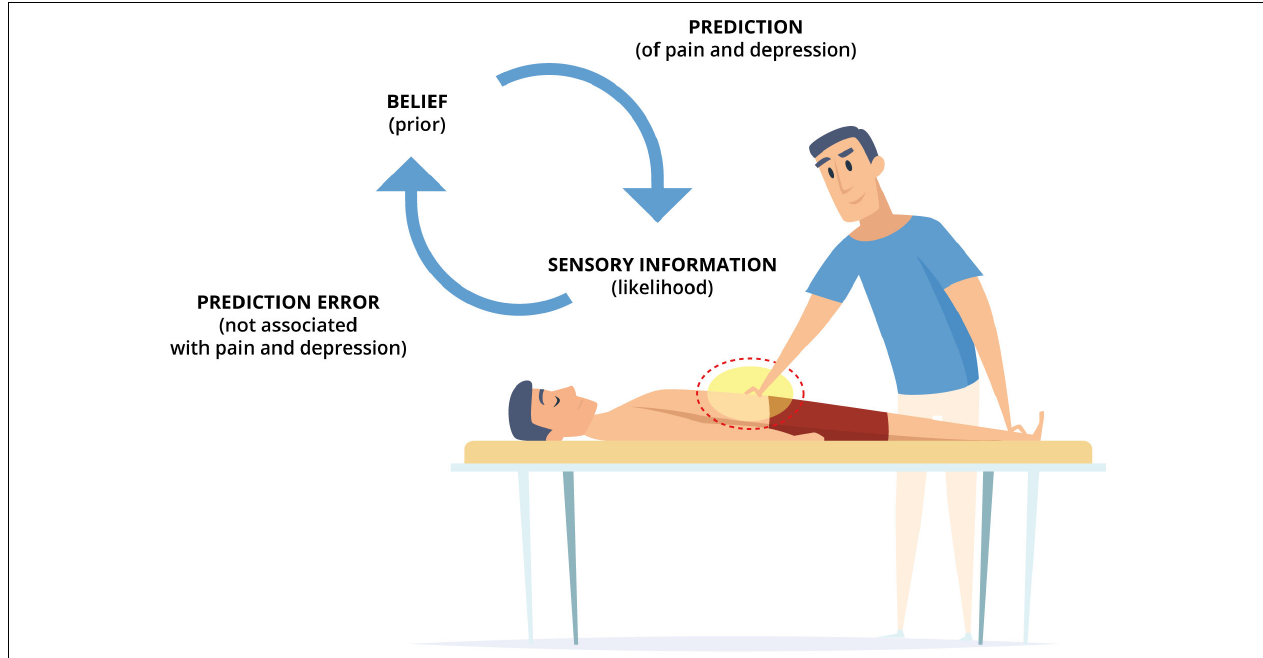
FIGURE 2 | An embodied, predictive, and interoceptive framework to osteopathy and mental health. A patient with chronic pain and comorbid depression is lying in supine position, while the therapist applies osteopathic treatment strategies (e.g., providing touch-based interventions to the symptomatic bodily area). Arguably, the belief (prior) of the patient predicts physical and mental states associated with pain and depression to be the likely causes of uncertain sensory information (likelihood). However, if the provided treatment (sensory input) is not linked to these physical and mental states, this surprising mismatch between expected and actual interoceptive information generates interoceptive prediction errors. These interoceptive prediction errors are subsequently minimized using active and perceptual inference processes. If, in chronic pain and depression, high precision is afforded to the belief (prior) and low precision is afforded to the sensory information (likelihood), active inference processes are engaged which produce symptoms resembling the predicted physical and mental states associated with pain and depression through autonomic nervous system activity. However, in a healthcare setting, this might not sufficiently reduce and explain interoceptive prediction errors. Consequently, perceptual inference processes are engaged to update the prior (belief) based on the likelihood (sensory information) thus revising the generative model holding the belief and issuing the prediction. These processes, arguably, underpin osteopathic treatment and putatively reduce (the belief about and prediction of) physical and mental states associated with pain and depression by updating persistent and noisy interoceptive prediction errors (which maintain symptoms through active inference) with surprising and precise interoceptive prediction errors (which alleviate symptoms through perceptual